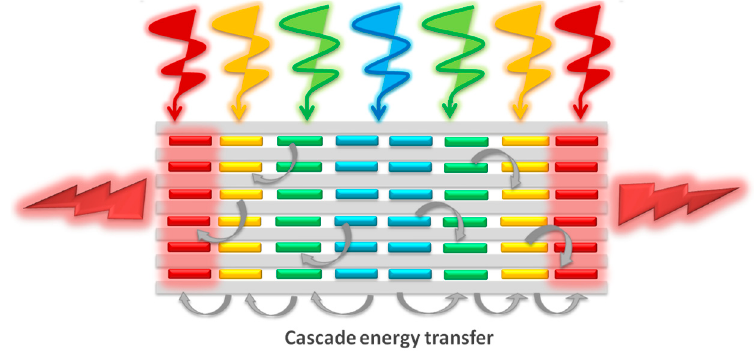
Figure 1. Schematic overview of an artificial luminescent antenna.